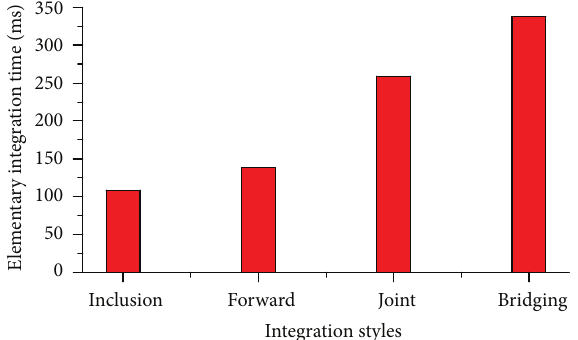
Figure 12: Testing results for elementary integration